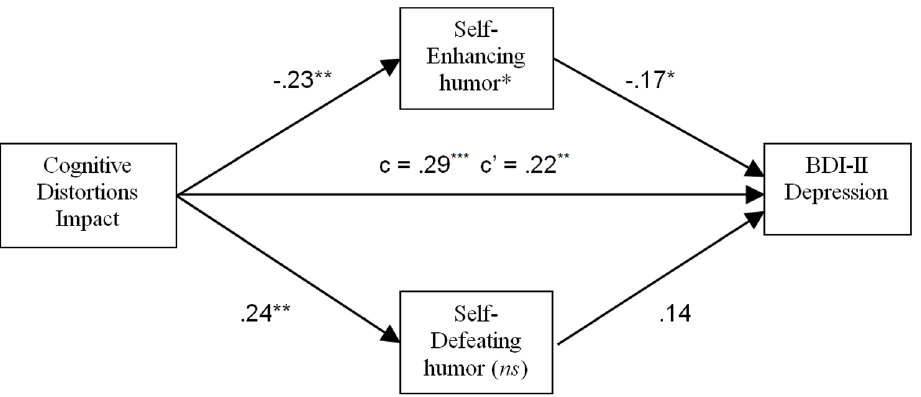
Figure 4. Mediating effect of Self-Enhancing humor on the relation between impact of cognitive distortions and depressive